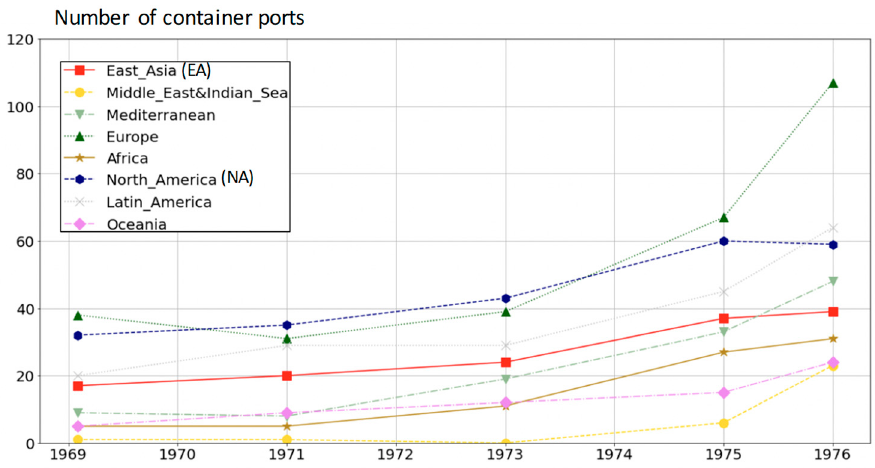
Figure 8. Number of container ports in each region of the world (1969–1976).